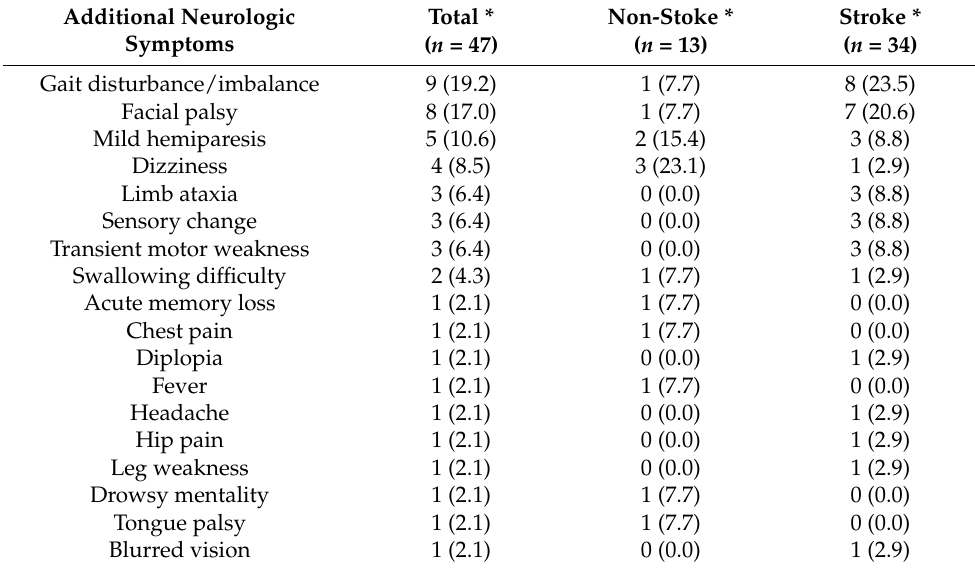
Table 3. Various additional symptoms in patients with prominent